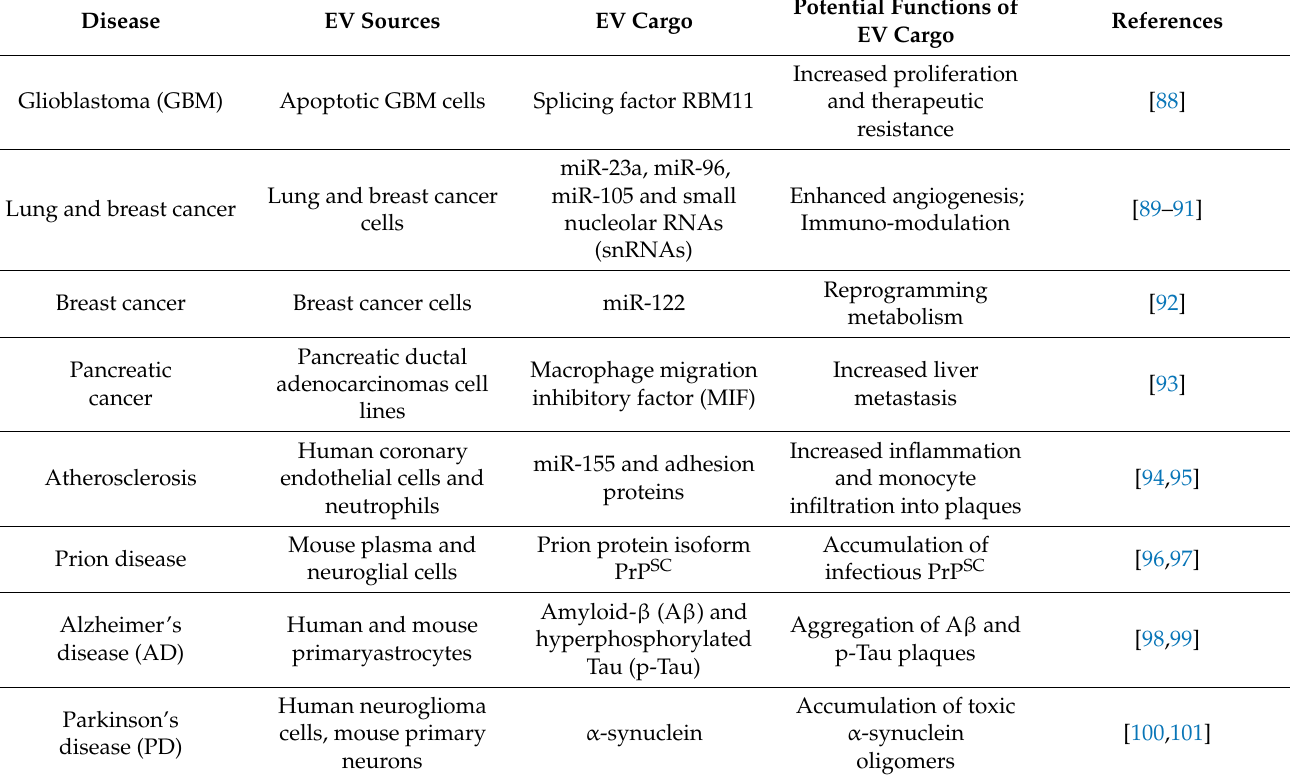
Table 1. Examples of pathological diseases associated with EV cargo